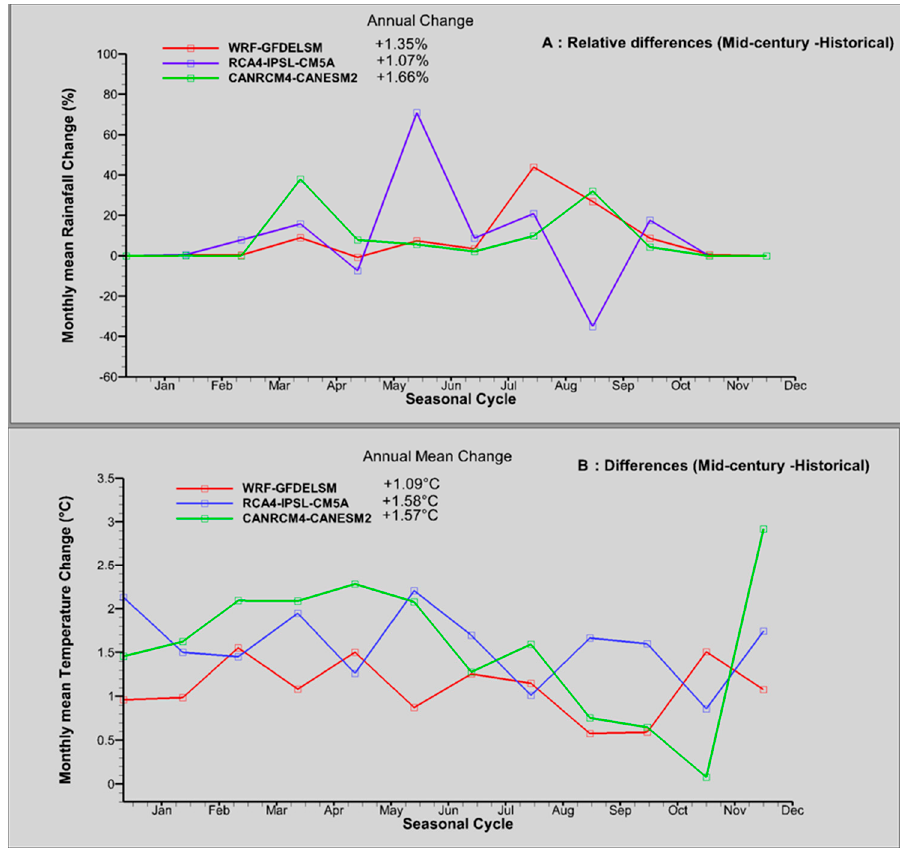
Figure 9. Rainfall and temperatures changes between 2020–2050 (mid-century) and 1980–2005 (historical) at Niamey Airport Station. ( A ) Relative di ff erences (Mid-century -Historical); ( B ) Di ff erences (Mid-century